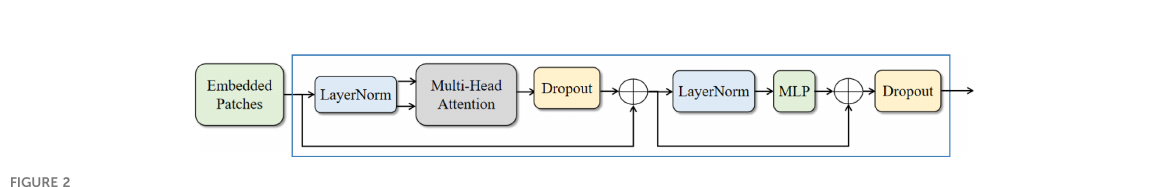
FIGURE 2 Structure of transformer encoder block (Zhu et al., 2021).